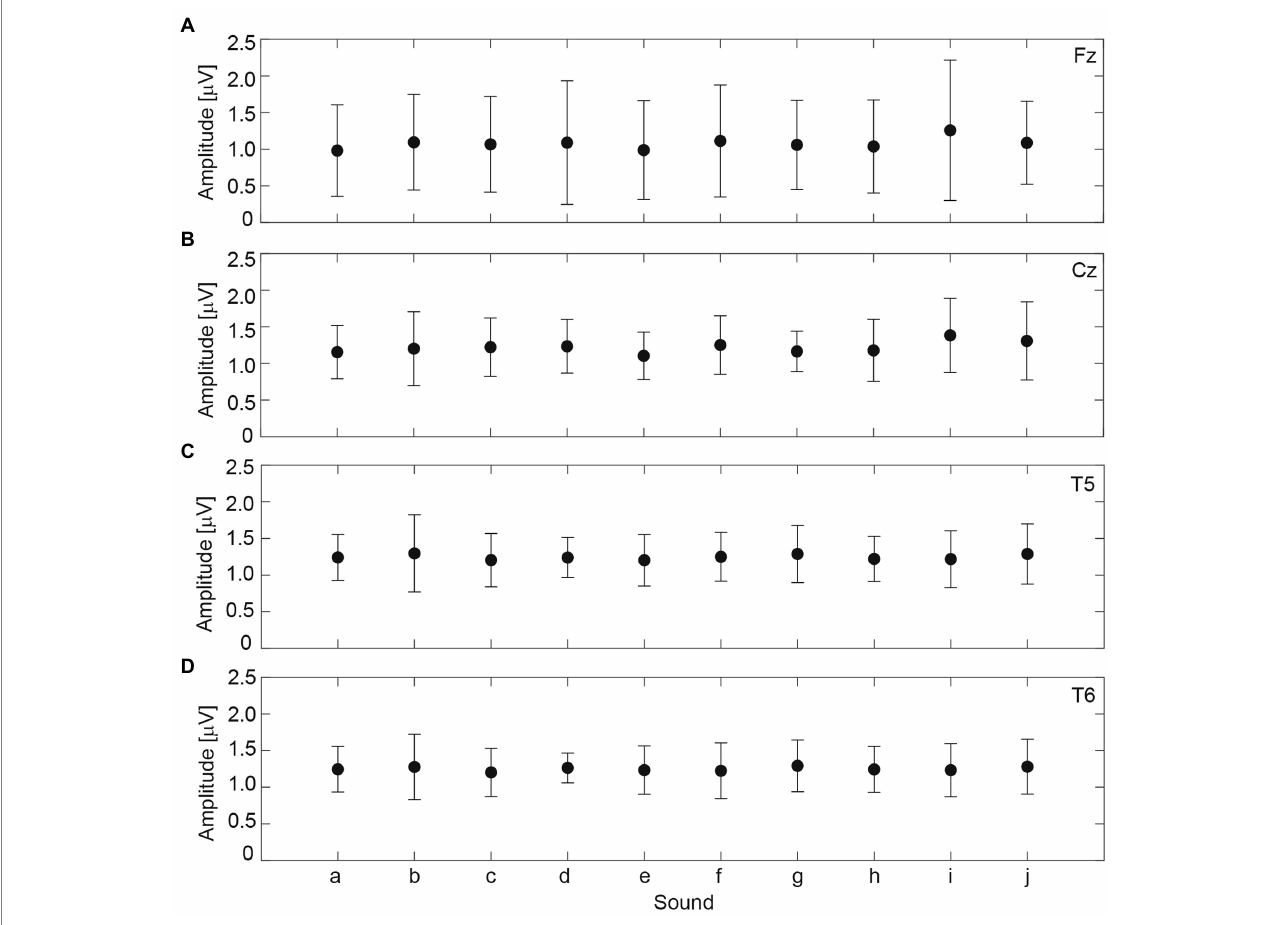
FIGURE 8 The mean root mean square (RMS) amplitude at electrode positions (A) Fz, (B) Cz, (C) T5, and (D) T6 from 14 participants. Each symbol indicates the averaged value, and error bars indicate standard deviations.